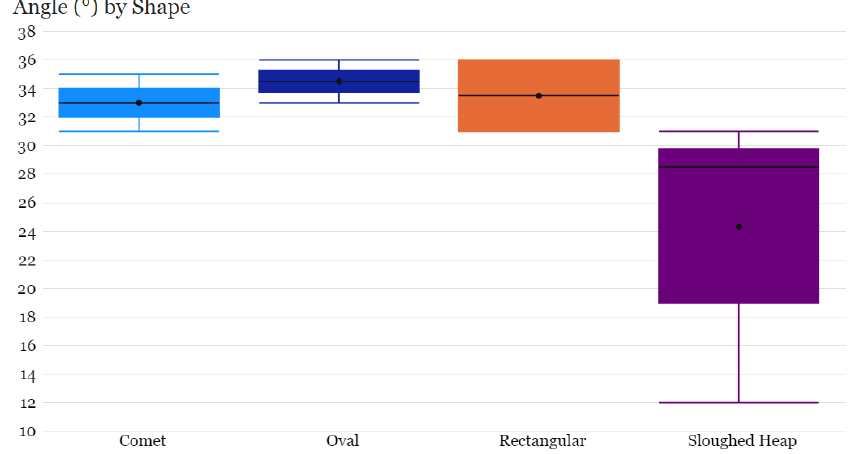
Figure 2. Box Charts of Volume (m 3 ) by Dump Profile Shape.